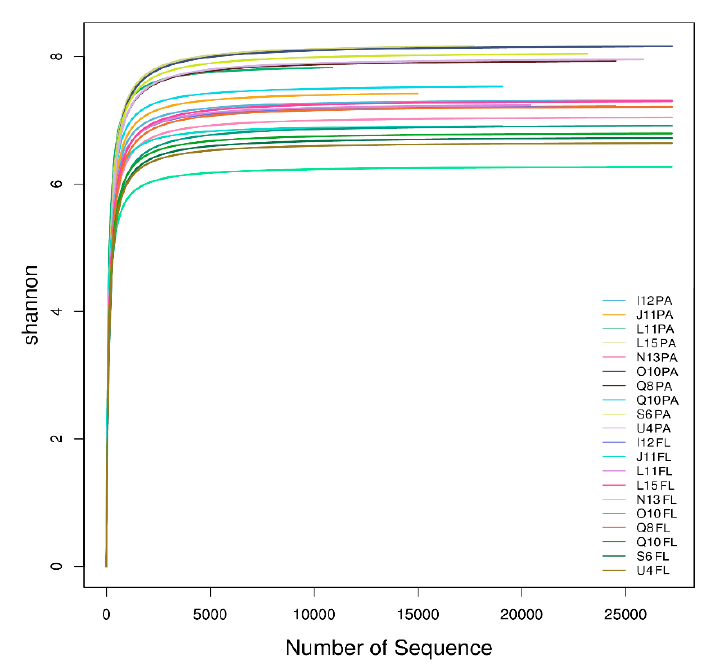
Figure A1. Rarefaction curves.